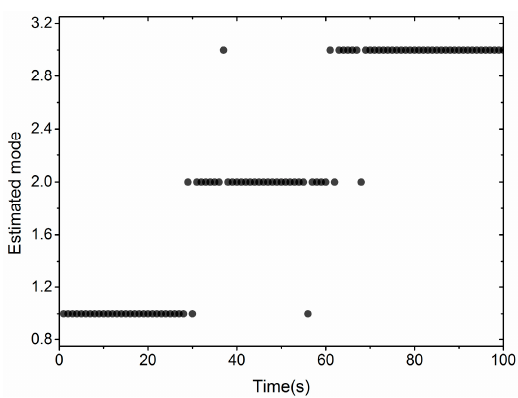
Figure 6. The model probabilities by using UIMM in simulation 1.